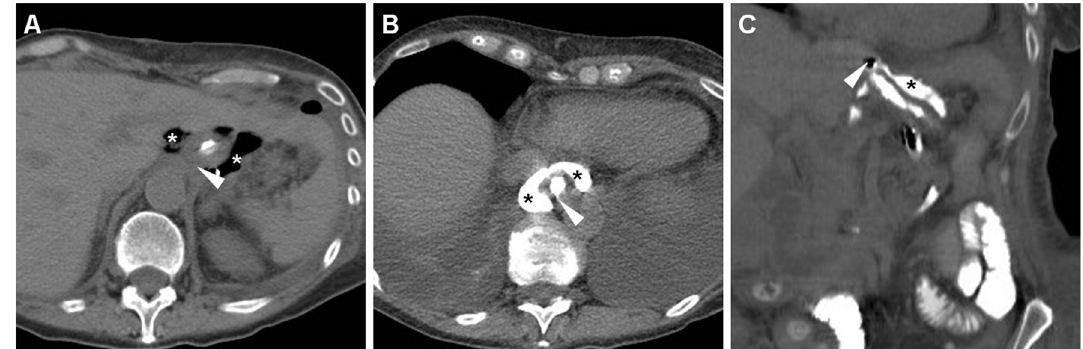
Fig. 13 In a 76-year-old woman with T4 N2 gastric cancer, three days after total gastrectomy unenhanced CT (A) showed minimal residual pneumoperitoneum and extensive air (*) surrounding the EJS (arrowheads). Repeated unenhanced CT with oral contrast administration (B, C) showed patent EJS (arrowheads) and